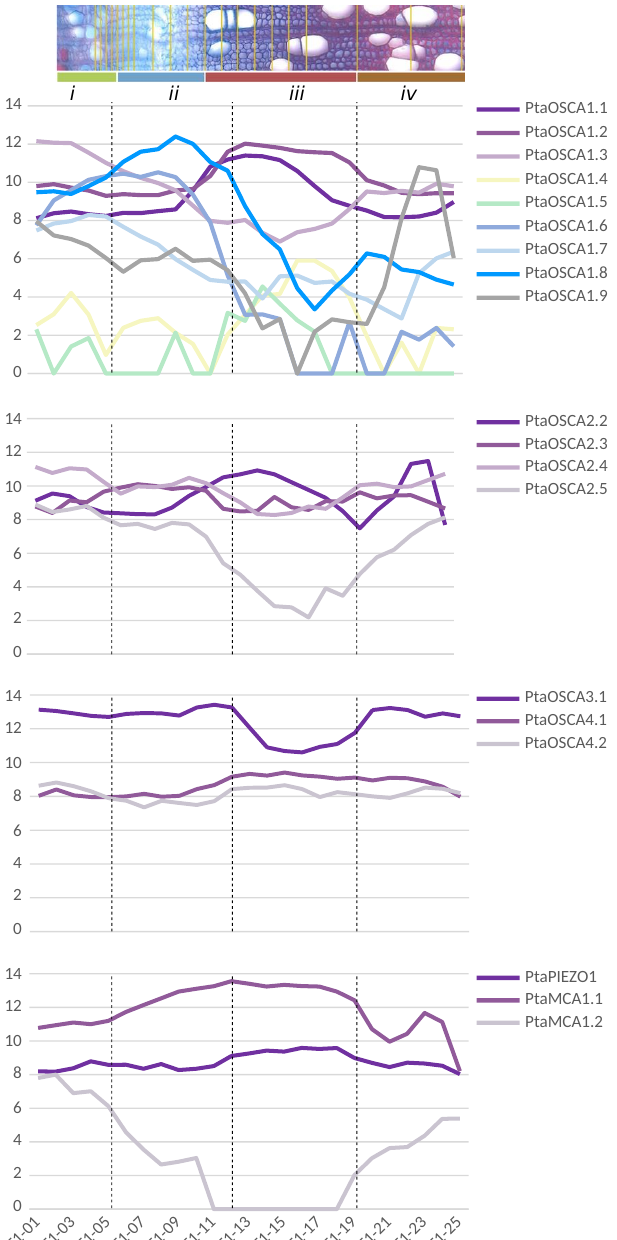
Figure 6. Expression patterns of MCA , Piezo and OSCA genes in the wood-forming tis- sues of a wild-growing aspen genotype ( Populus tremula ). Data were retrieved from Sundell et al. ([129]; Supplementary Dataset 2). Pooled longitudinal tangential cryosections were used to obtain a continuous sequence of samples extending from differentiated phloem to mature xylem, with values of expression levels ranging from 0 to 16 (see Appendix B.3 for details). To better illustrate the location of the different tangential cryosections pooled to produce an RNA-seq sam- ple, we showed the transverse cross-section image from the sampled tree T1 from ([129], Figure 1). The pooled samples are visualized by overlaying them on the transverse cross-section and are grouped into four clusters (from i to iv ). These clusters separate key reprogramming events repre- sented by the dashed lines: ( i/ii ) occurs between phloem and xylem differentiation, in the middle of the dividing cambial cells; ( ii/iii ) marks the end of cell expansion and the onset of secondary cell wall formation; ( iii/iv ) marks the end of secondary cell wall deposition and the late maturation of xylem cells. The cambium zone is located in cryosections T1-04, T1-05 and